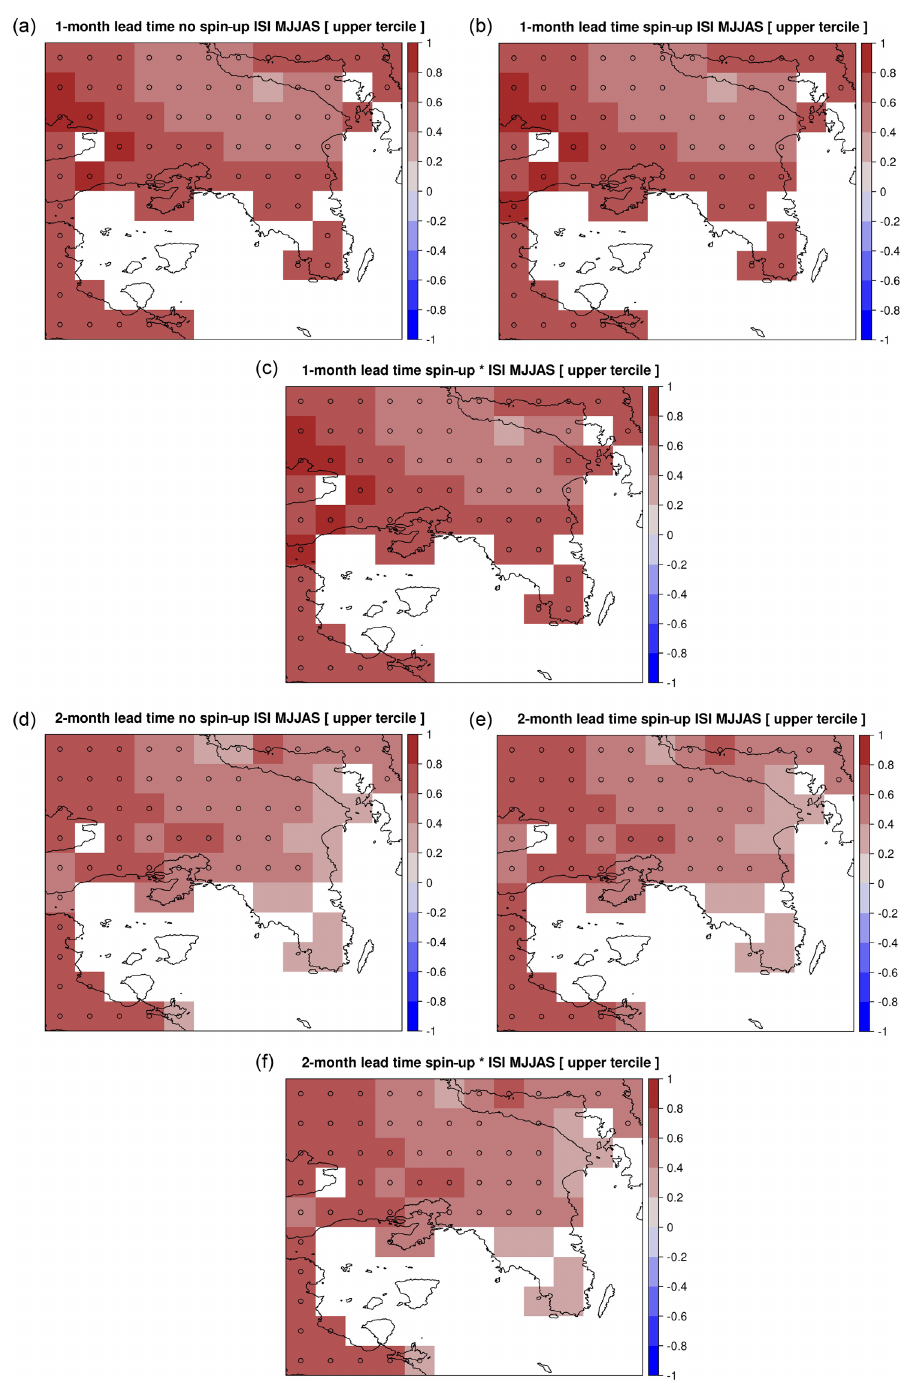
Figure 5. Same as Fig. 2 but for ISI